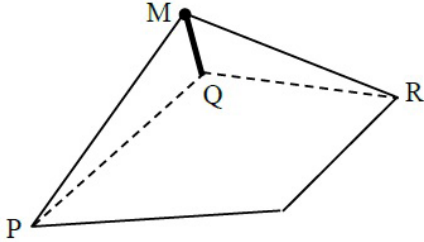
Figure 17: New point is outside QR.